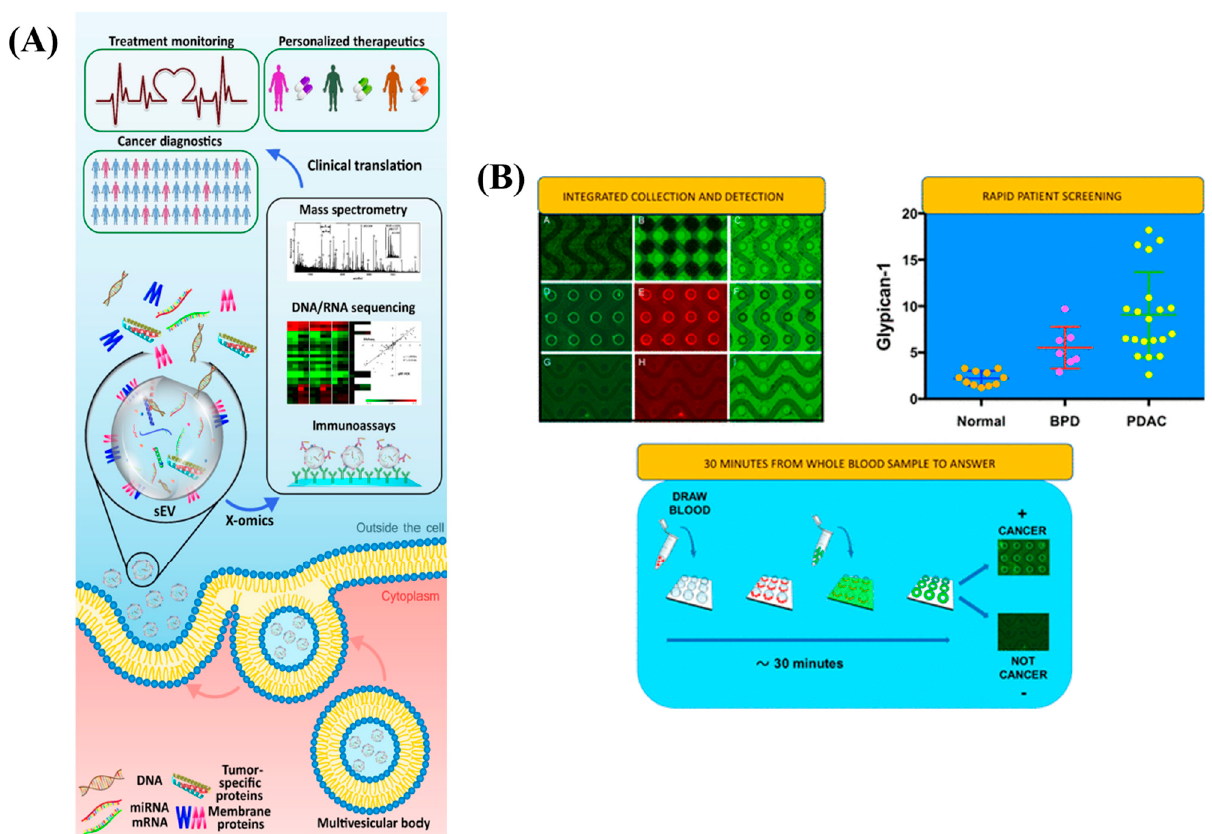
Figure 8. ( A ) Extracellular Vesicles as Next Generation Liquid Biopsy Biomarkers. Re-used with permission from Ref. [68]. (Copyright, 2021 Elsevier, reproduced with permission from Elsevier Ltd.). ( B ) ACE direct immunoassay procedure and its related results in whole blood and plasma/serum from pancreatic cancer patients. Re-used with permission from Ref. [80]. (Copyright 2018, American Chemical Society).